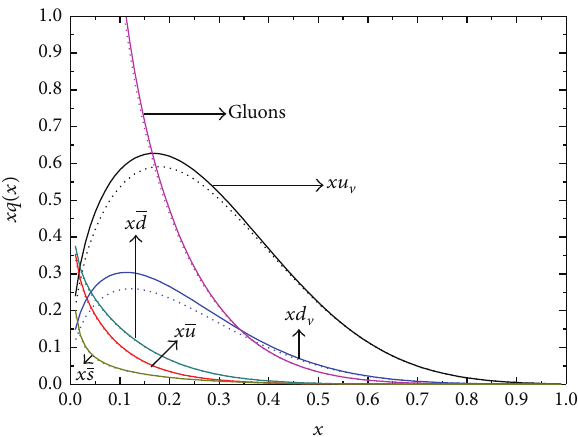
Figure 8: Distribution function of valance and sea quarks inside 195 Pt nucleus at 𝑄 2 = 20 GeV 2 . The full curve is obtained by considering the pionic contribution and the dashed line is plotted without considering the pionic contribution.